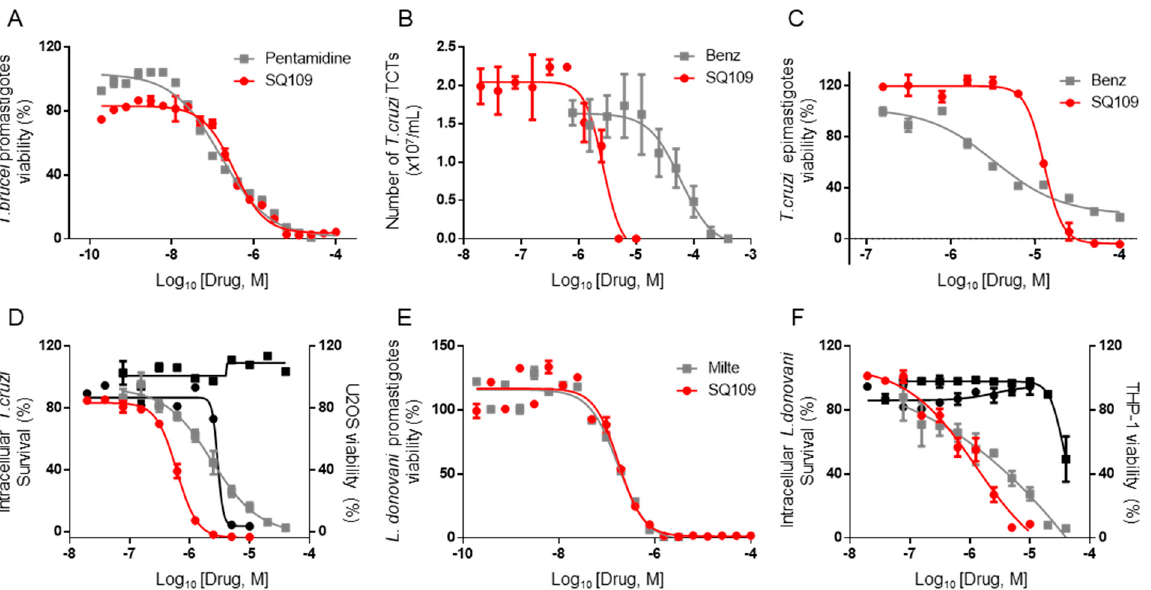
Figure 2. In vitro activity of SQ109 against kinetoplastid parasites. ( A ) Viability of T. brucei trypo- mastigotes treated with pentamidine [ ■ ] or SQ109 [ ● ] for 72 h. ( B ) Number of T. cruzi TCTs (tissue culture trypomastigotes) treated with benznidazole [ ■ ] or SQ109 [ ● ] for 24 h. ( C ) Viability of T. cruzi epimastigotes treated with benznidazole [ ■ ] or SQ109 [ ● ] for 72 h. ( D ) Survival of intracellular T. cruzi amastigotes in U2OS treated with benznidazole [ ■ ] or SQ109 [ ● ] and viability of U2OS treated with benznidazole [ ■ ] or SQ109 [ ● ] for 72 h. ( E ) Viability of L. donovani promastigotes treated with miltefosine [ ■ ] or SQ109 [ ● ] for 72 h. ( F ) Viability of intracellular L. donovani amastigotes in THP-1 followed by treatment of miltefosine [ ■ ] or SQ109 [ ● ] and viability of THP-1 treated with miltefosine [ ■ ] or SQ109 [ ● ] for 72 h.